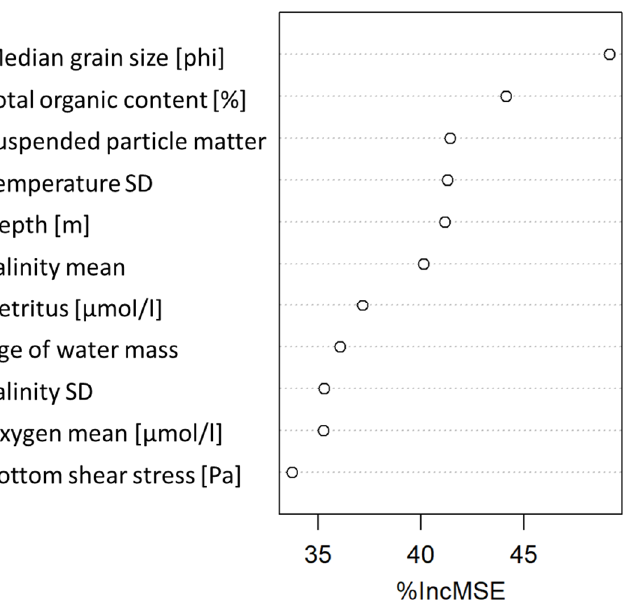
Figure 3. Importance of predictors driving regional distribution of BIPc in the final RF model quantified as the Mean Decrease Accuracy (%IncMSE).